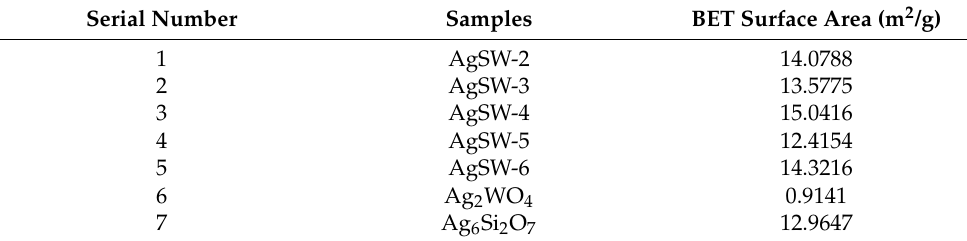
Table 1. BET-specific surface area of the